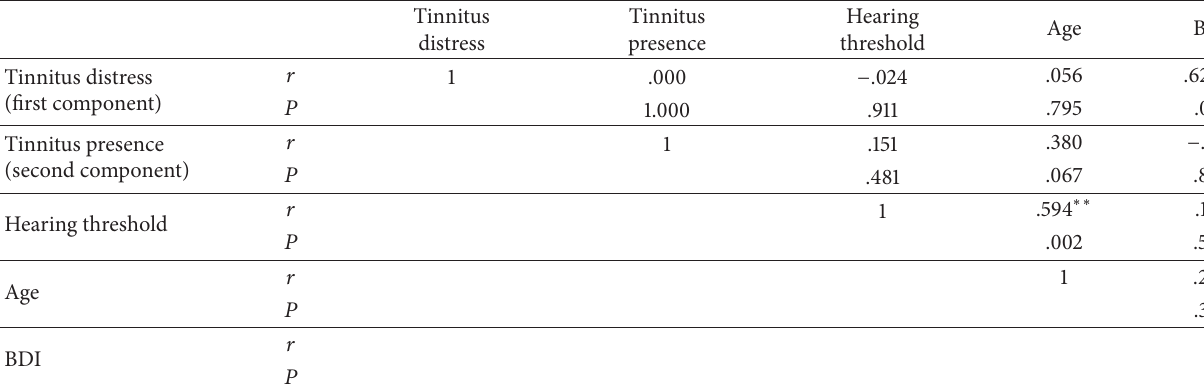
Table 4: Correlations between components and other variables.